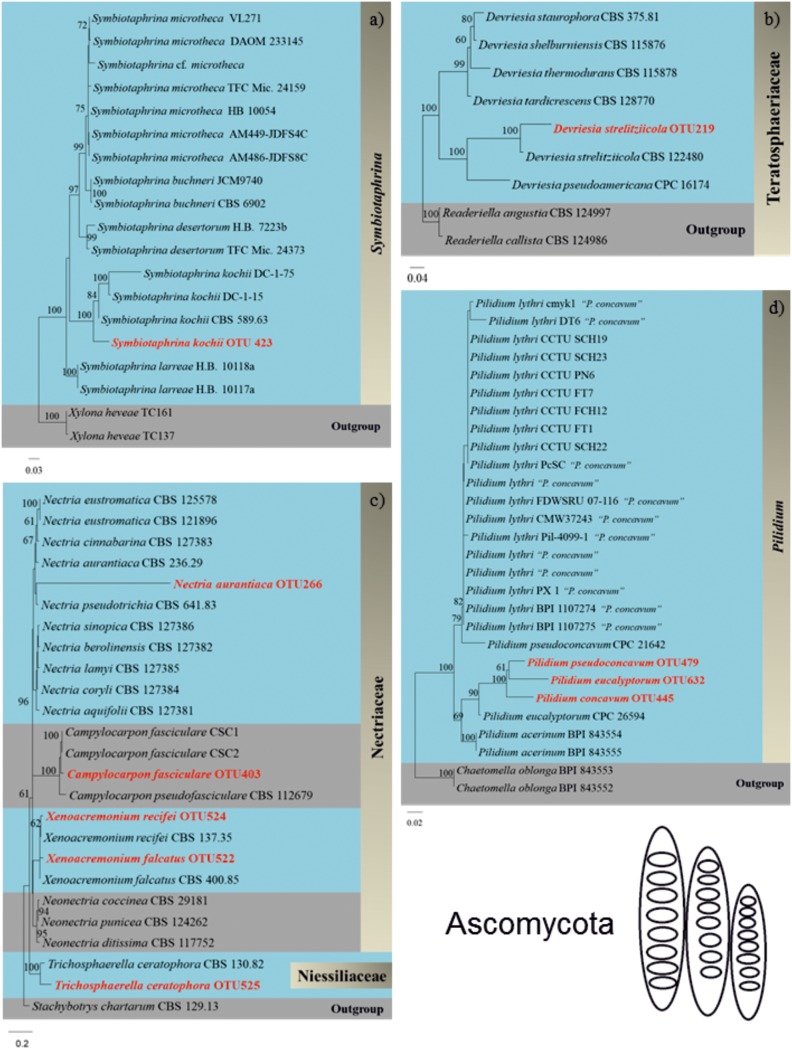
Phylograms (Ascomycota) of (a)
Symbiotaphrina kochii (Xylonomycetes), (b)
Devriesia strelitziicola (Dothideomycetes), (c)
Campylocarpon fasciculare, Xenoacremonium recifei, Xenoacremonium falcatus, Nectria aurantiaca, and Trichosphaerella ceratophora (Sordariomycetes), and (d)
Pilidium concavum, Pilidium pseudoconcavum, Pilidium eucalyptorum (Leotiomycetes) generated by randomized axelerated maximum likelihood analysis based on complete ITS sequences.